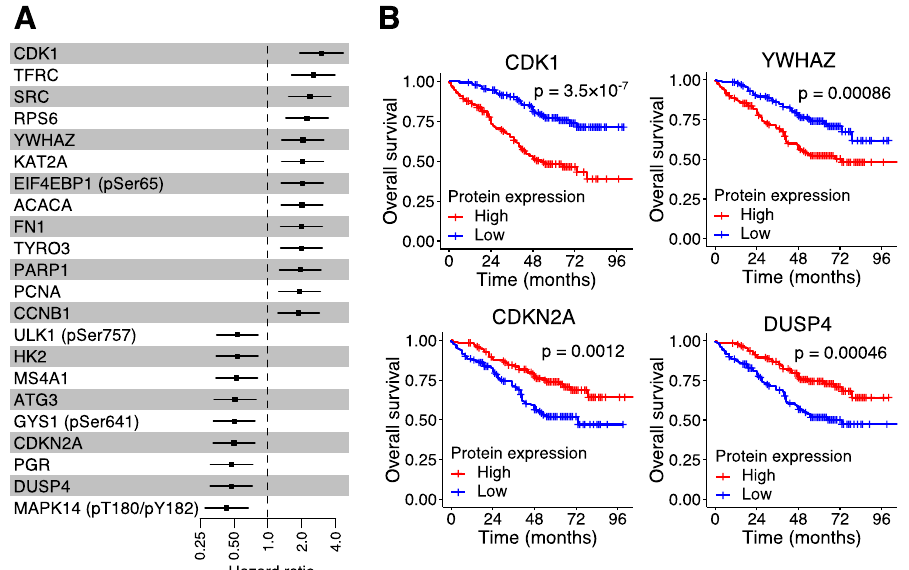
Fig.6 |Prognosticimpactofproteinexpressionlevelsintumor.A Hazardratio foroverallsurvival. Foreachof 293proteinsmeasured by RPPA,259patients were strati fi ed into high- or low-expression groups based on the median expression levels, and their association with survival was computed using the Cox propor- tional hazard model. The p -values were adjusted for multiple hypothesis testing using the Benjamini – Hochberg method. Only proteins with FDR<0.05are